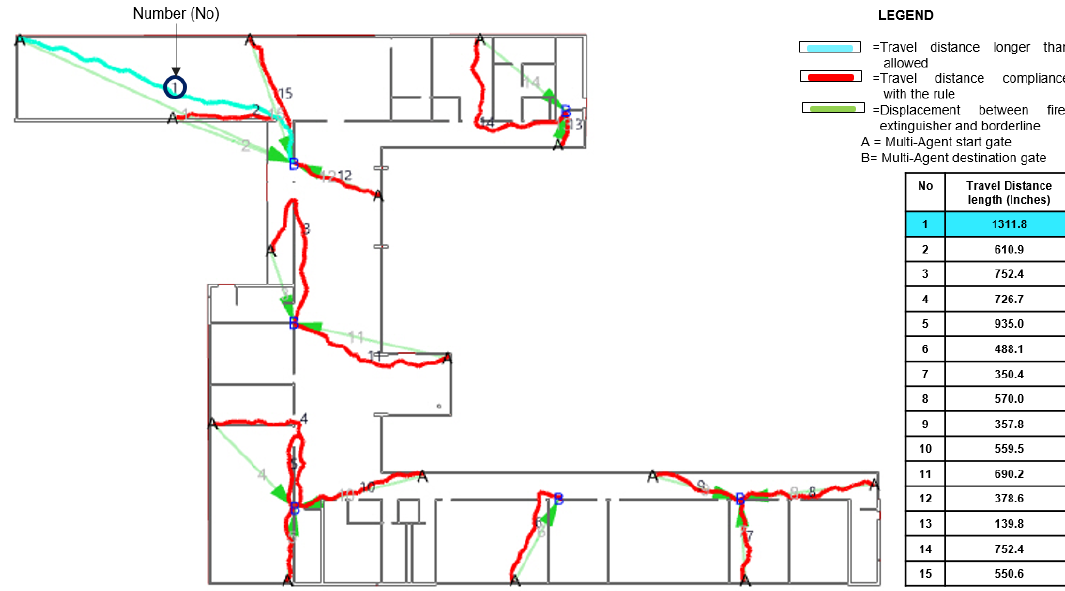
Figure 6. Multi-Agent Simulation for the Con-fire Safety Planning